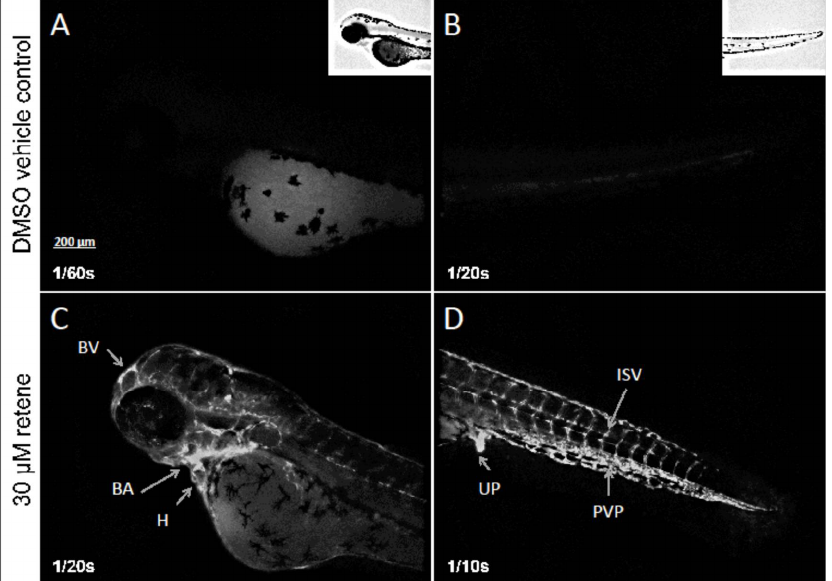
Figure 2. Whole-mount immunolocalization of zebrafish CYP1A protein in a representative DMSO vehicle (control) larva ( A , B ) and 30 µM retene-exposed ( C , D ) larvae at 48 hpf using mAb CRC2. Each larva was exposed to their respective treatment from 4 hpf through 48 hpf. BA, brachial vasculature; BV, brain vasculature; H, heart; UP, urogenital pore; PVP, posterior vascular plexus; ISV, intersegmental vessel. Details are found in Methods.